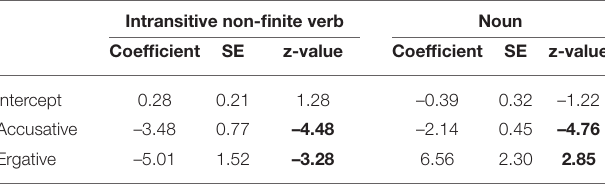
TABLE 6 | Glmer results for the non-finite verb and noun completions Experiment 2. The analysis uses treatment contrast, with the Locative condition as the baseline with the coefficient signifying the difference from the baseline.